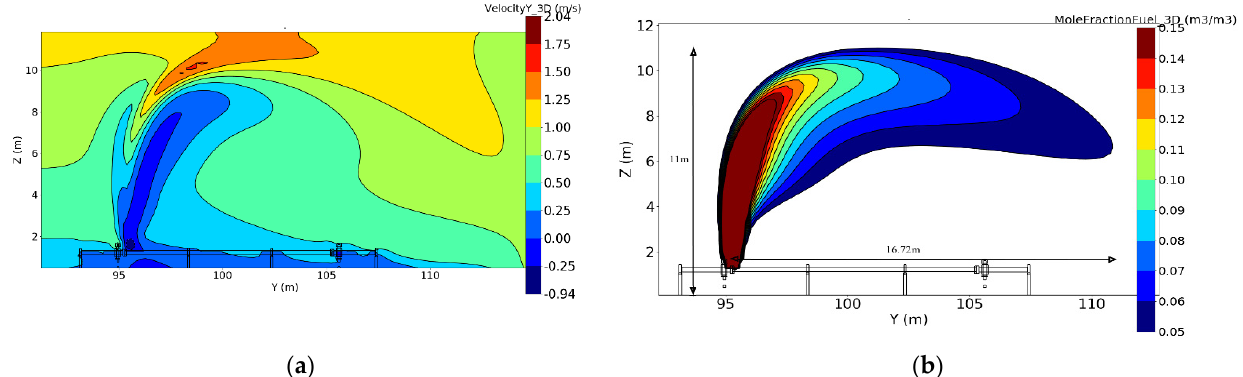
Figure 5. ( a ) Section view of wind speed distribution in the vertical upward leak; ( b ) section view of the vertical upward leak showing LFL distance of 16.72 m.